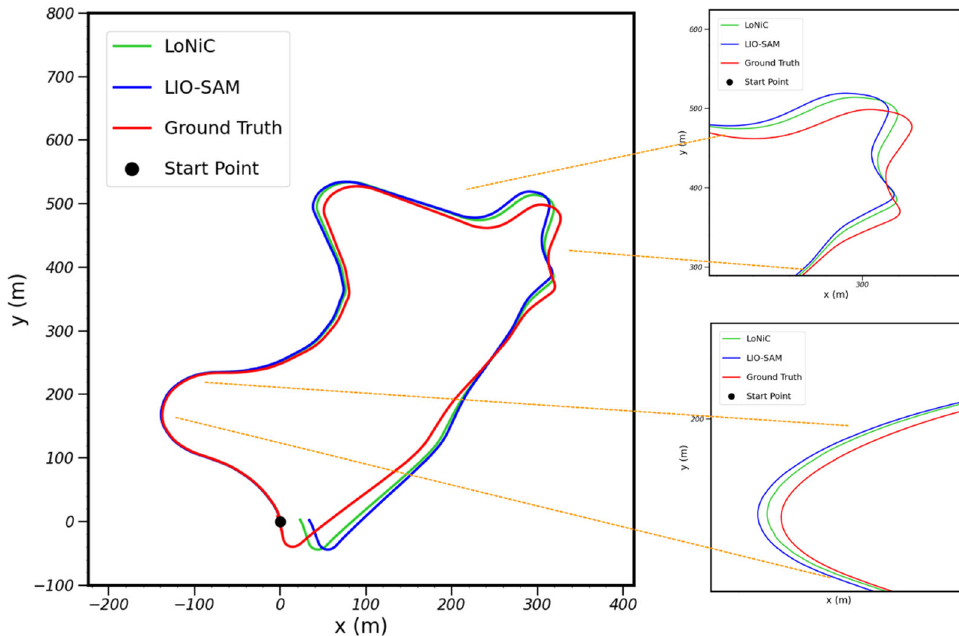
Figure 12. Trajectory comparison of sequence 09 on the KITTI dataset.